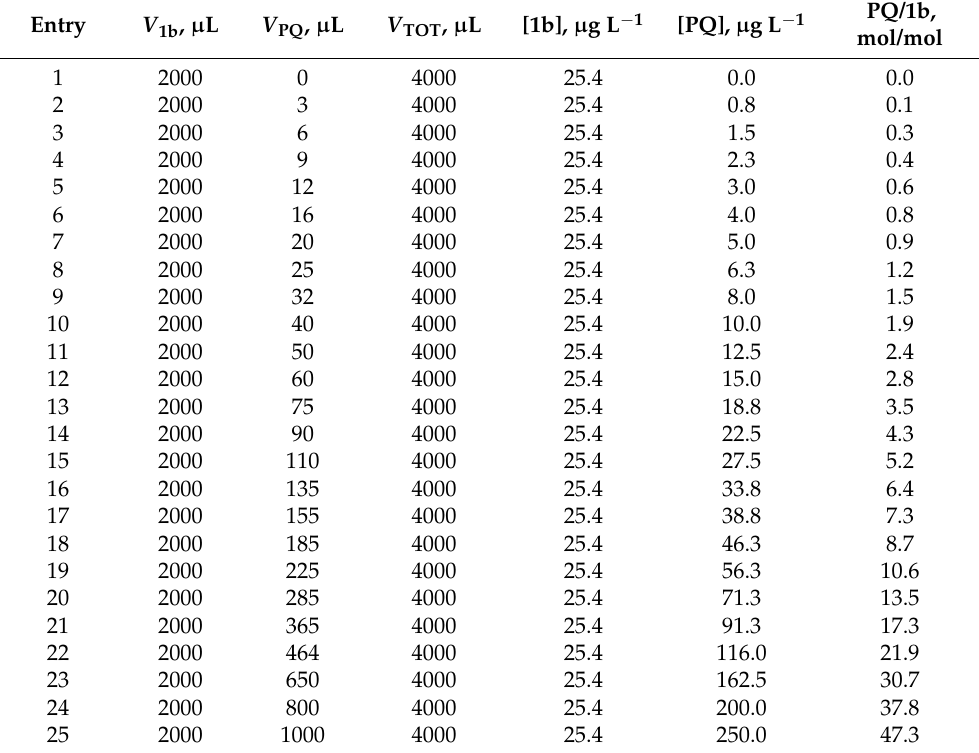
Table 2. Experimental data for the determination of spectra reported in Figure 4. The V 1b and V PQ volumes refer to an initial 1b solution with a concentration of 50.7 µ g L − 1 and paraquat, PQ, solution with a concentration of 1000 µ g L − 1 , respectively. The final volume of each solution was made up to a total volume of 4000 µ L by fixing with the solvent mixture.